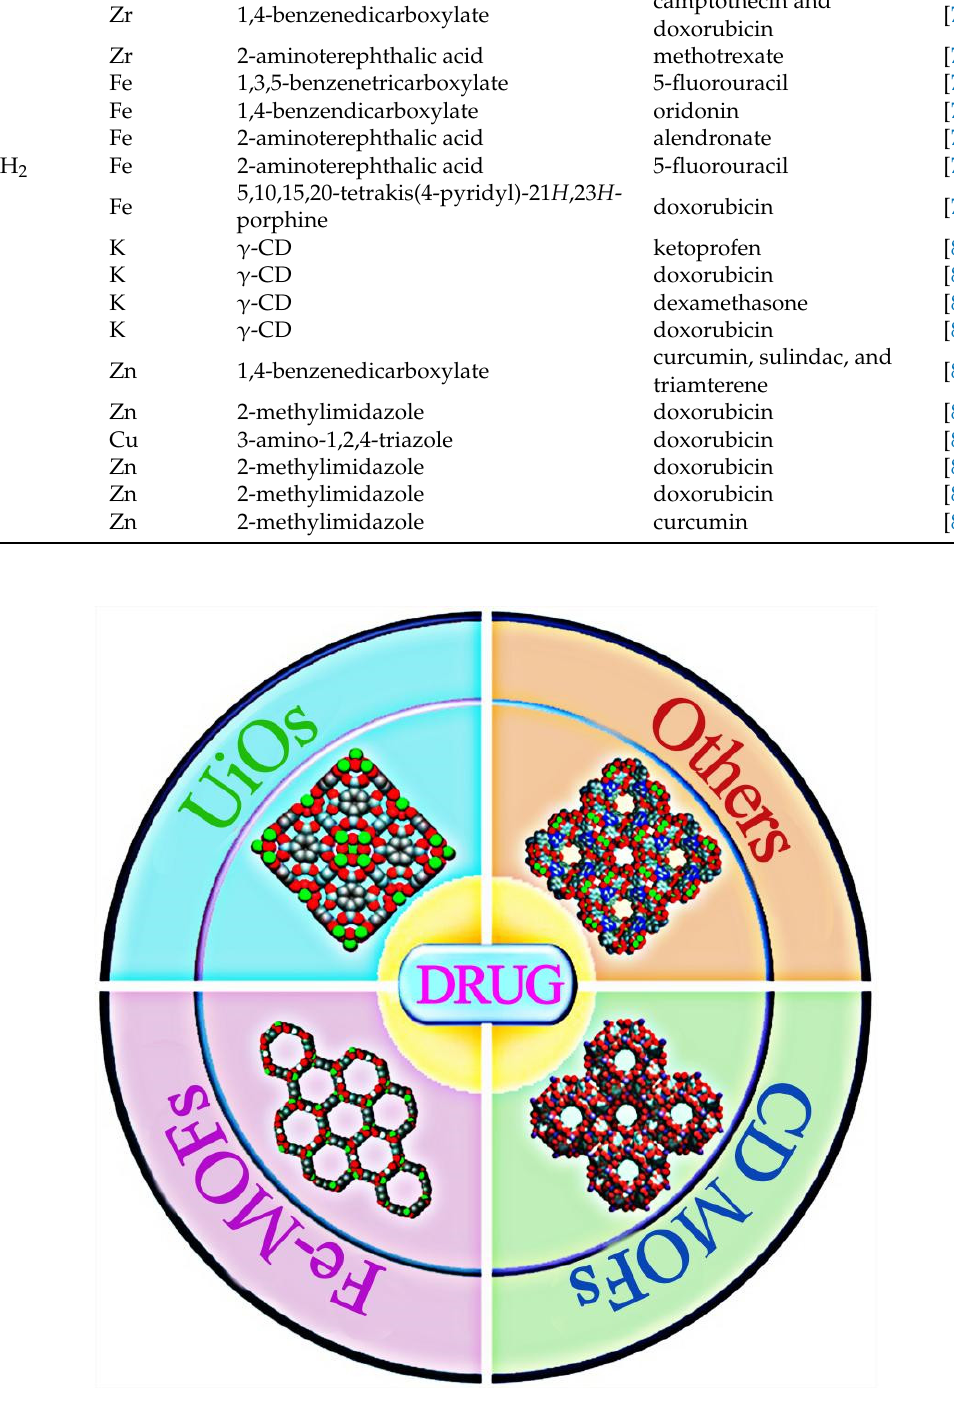
Table 1. Some representative MOF-based nanocarriers for drug